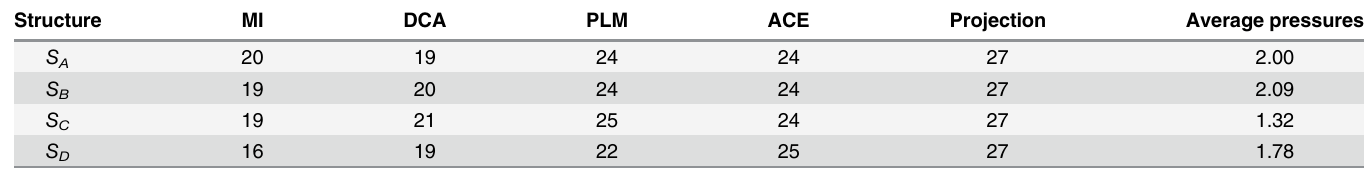
Table 2. Quality of contact prediction with the different methods of inference, and average pressure. Number of correctly predicted contacts after 28 predictions with the methods MI, DCA, PLM, ACE, and Projection, see Fig 2A, and pressures λ , defined in Eq [2], averaged over the pairs of amino acids in contact in the native